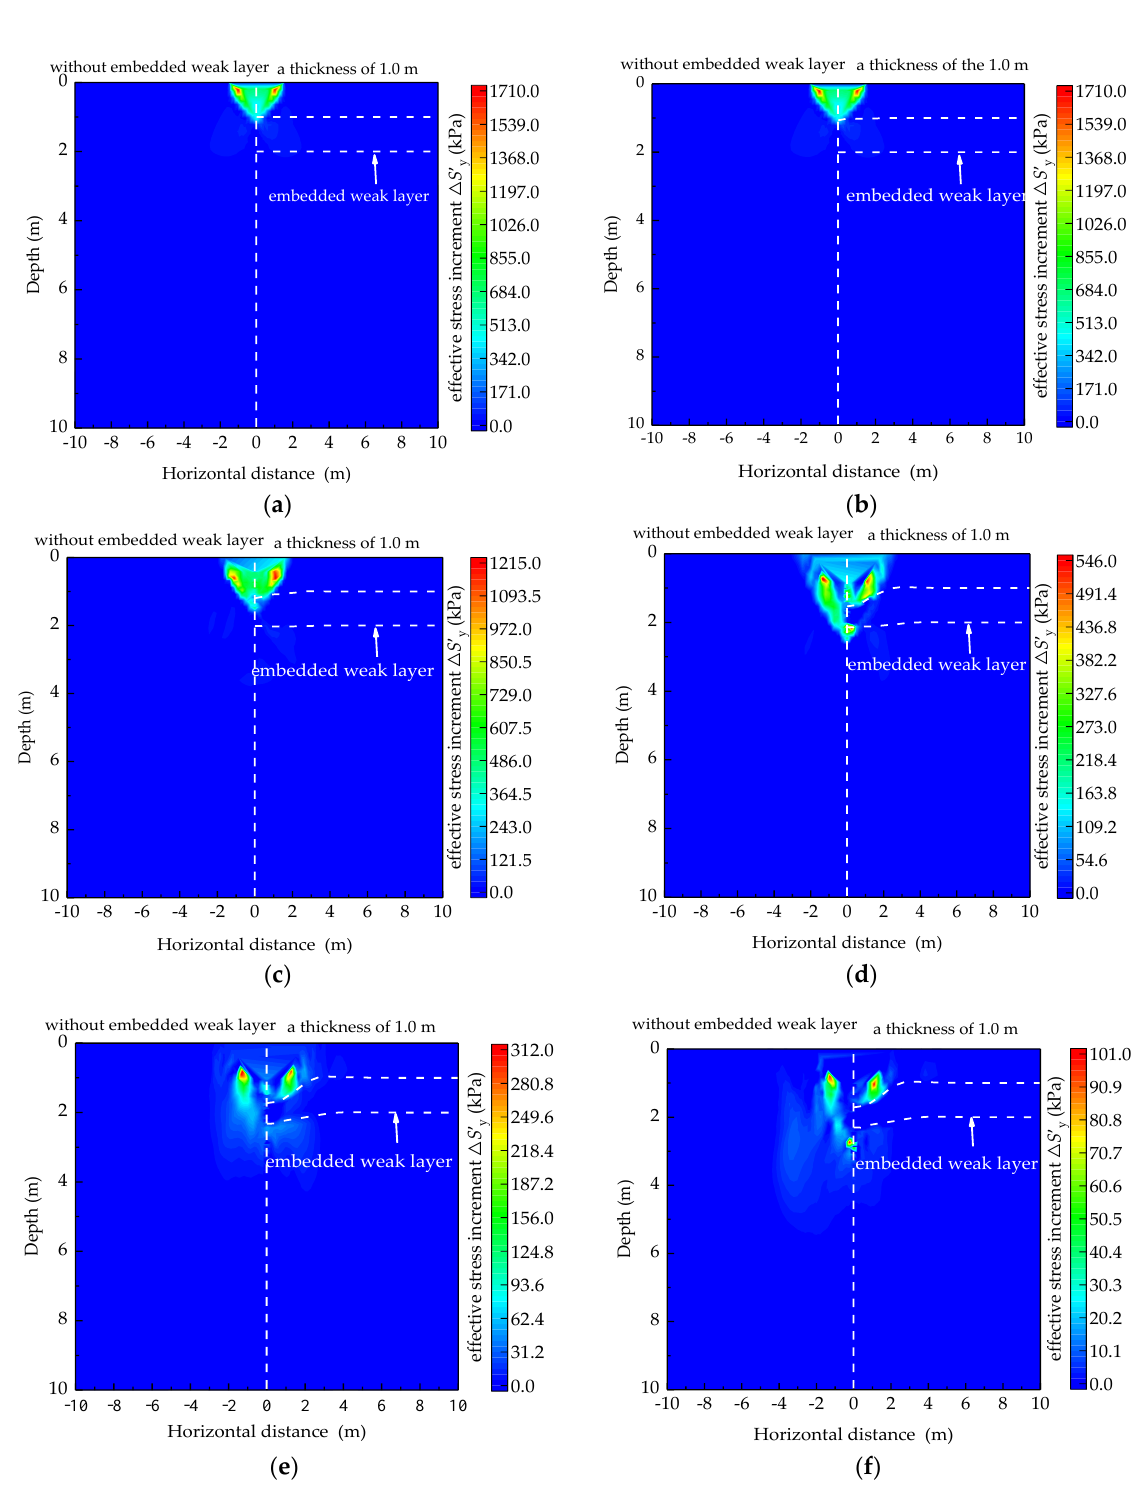
Figure 8. Distributions of Δ S ’ y in grounds with or without an embedded weak layer during DC. ( a ) t = 0.01 s; ( b ) t = 0.02 s; ( c ) t = 0.04 s; ( d ) t = 0.1 s; ( e ) t = 0.2 s; ( f ) t = 2.0 s.